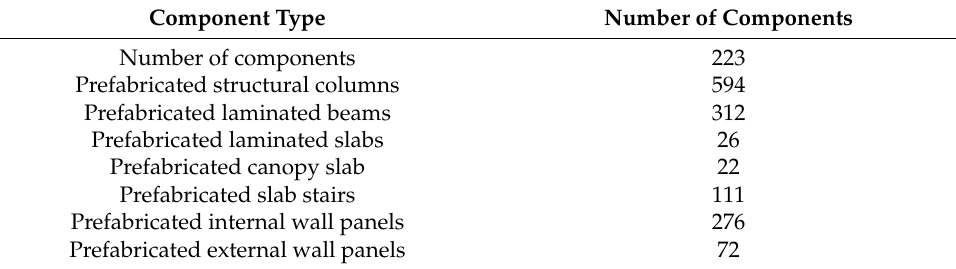
Table 5. Project Component